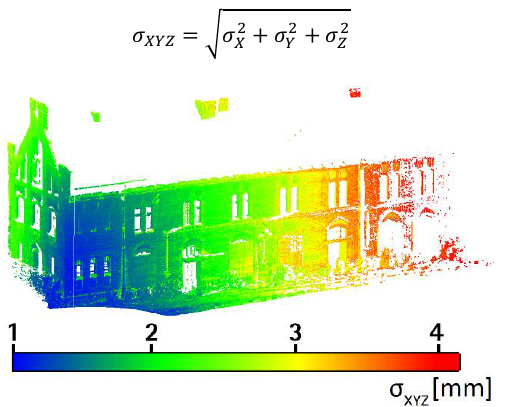
Figure 13. Example of estimated standard deviation of a 3D point (Helmert point uncertainty) for the precision of TLS measurements.